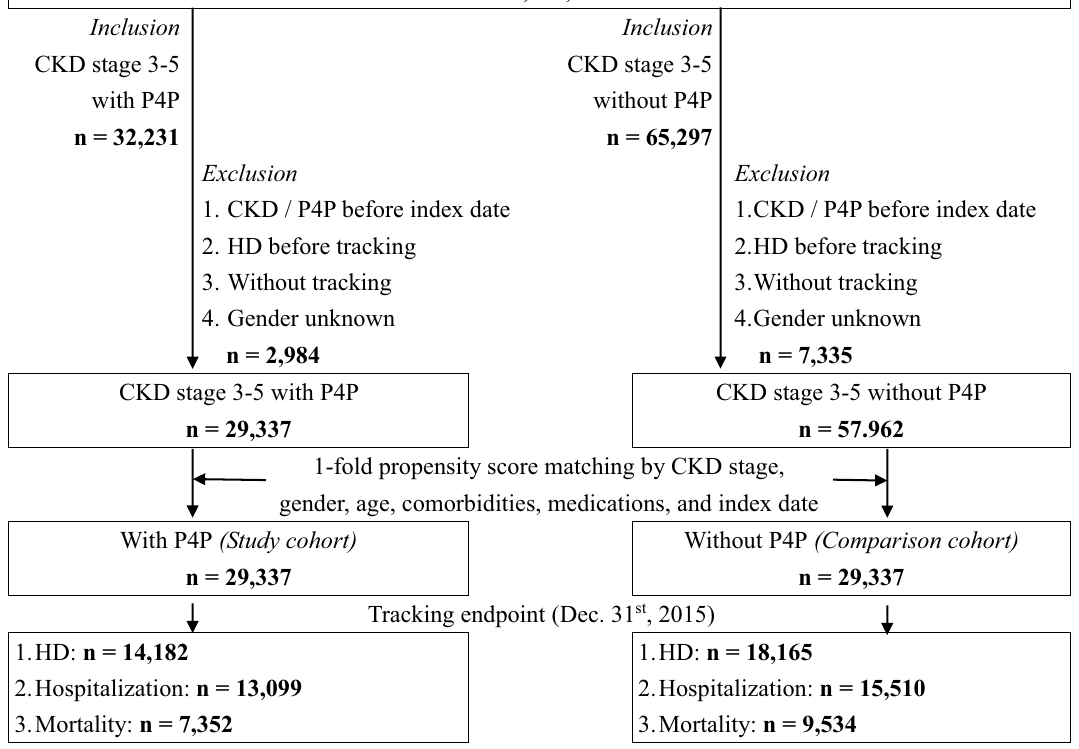
Figure 1. Cohort Assembly in This Study. Abbreviations: CKD = chronic kidney disease; HD = hemodialysis; P4P = pay for performance